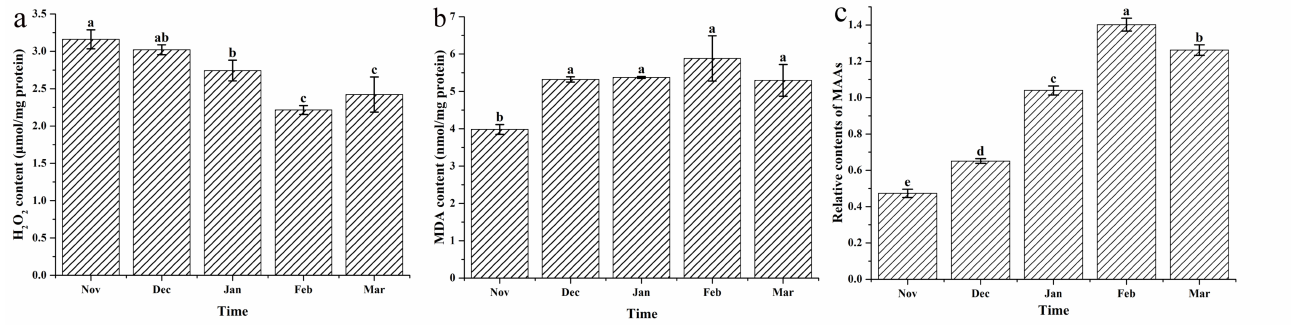
Figure 7. Variations of H 2 O 2 and MDA in N. yezoensis collected from different cultivation periods. ( a ) H 2 O 2 content, ( b ) MDA content, ( c ) Relative contents of MAAs. Data were Mean ± SD ( n = 3). Different letters indicated significant differences ( p <